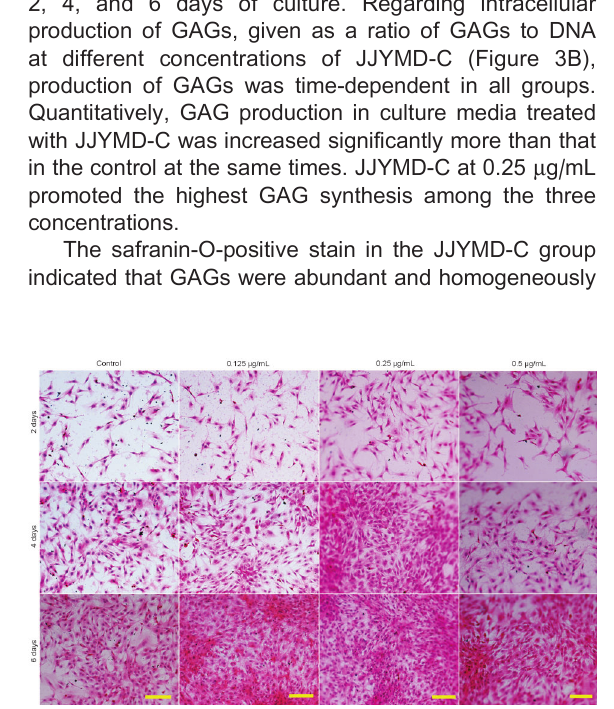
Figure 5. Hematoxylin-eosin staining showing the morphology of chondrocytes cultured in vitro with 0 (control), 0.125, 0.25, and 0.5 m g/mL JJYMD-C for 2, 4, and 6 days. Scale bar: 100 m m.